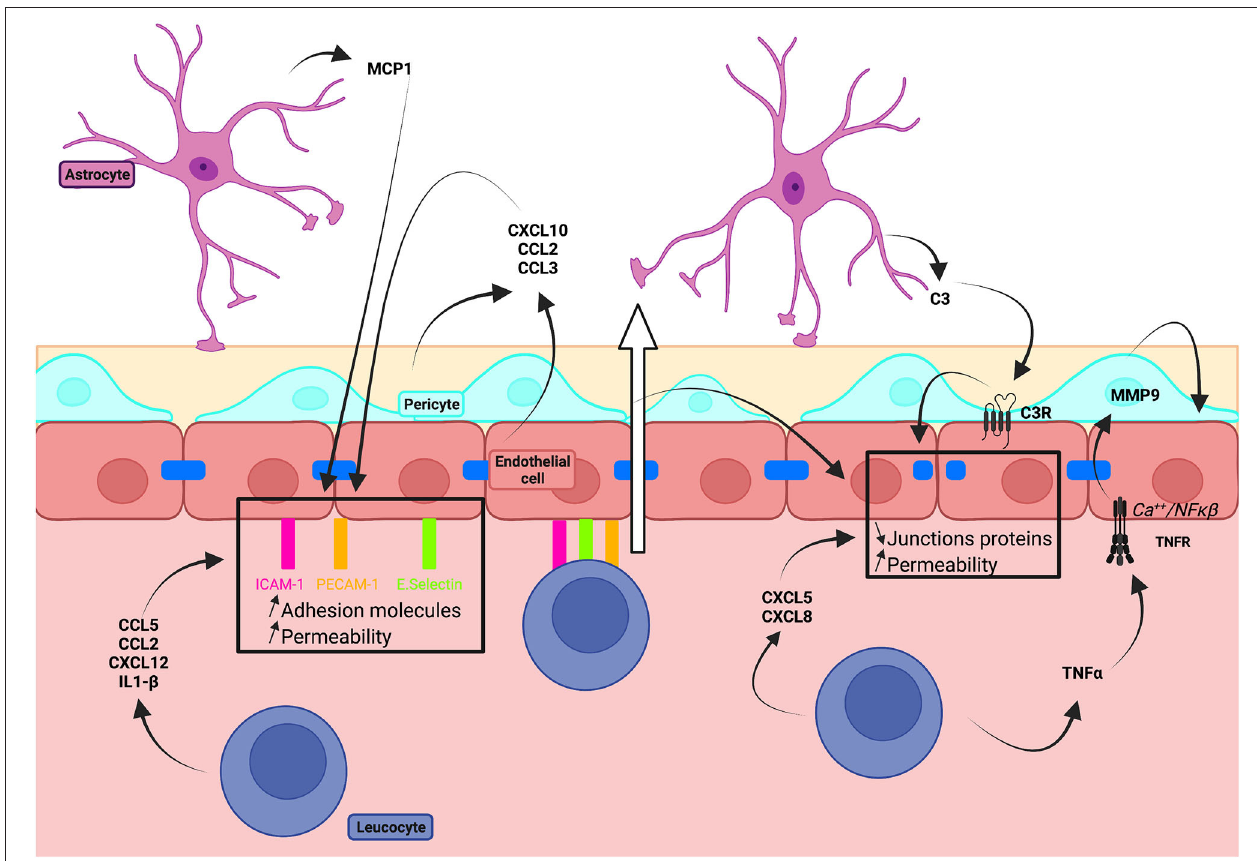
FIGURE 3 | Schematic illustration of the impact of inflammatory processes on BBB integrity.